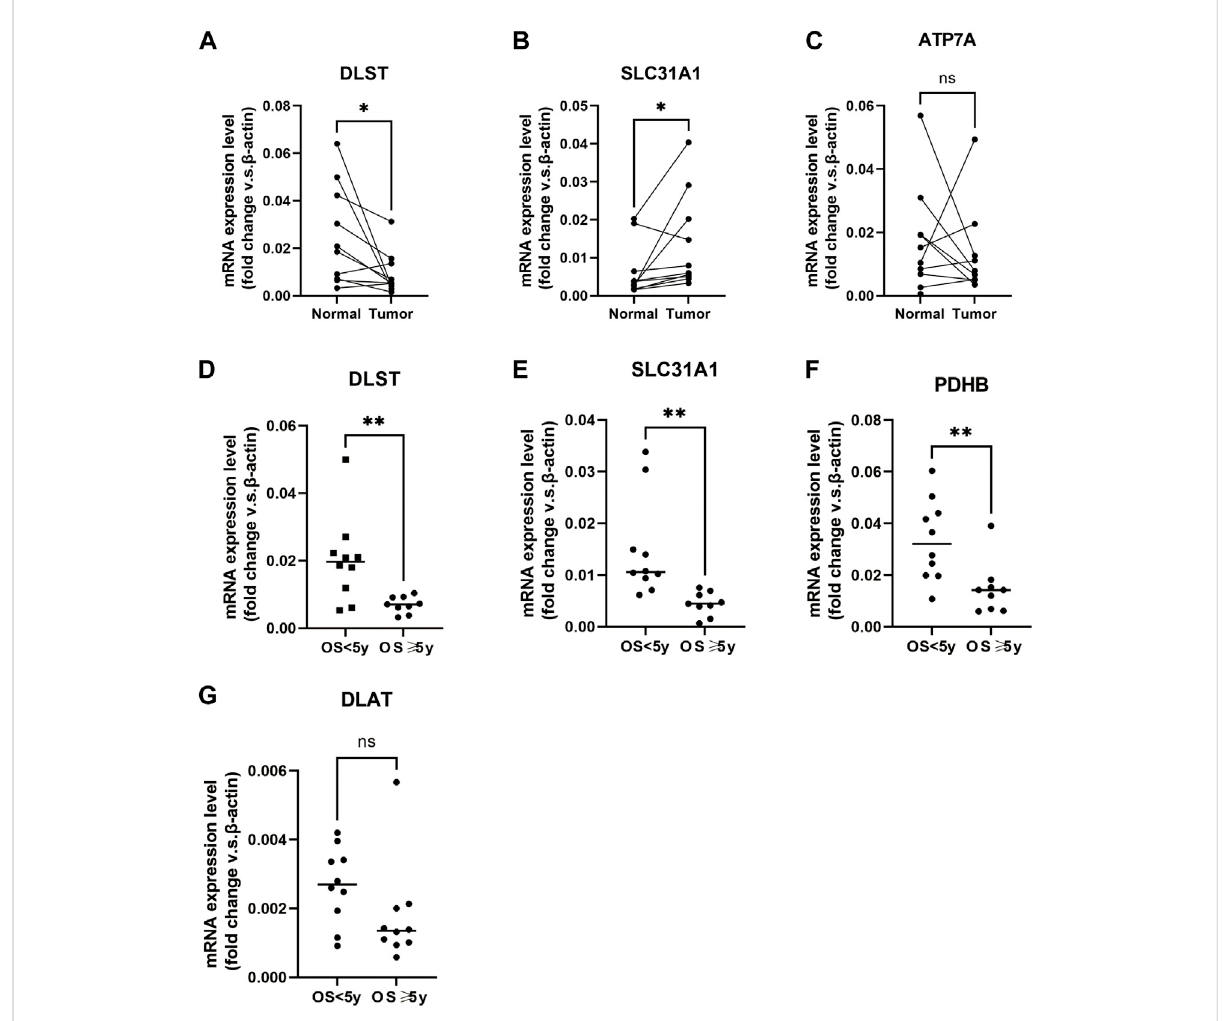
FIGURE 10 Veri fi cation of mRNA relative expression of the CuGs by qPCR (A – C) mRNA relative expression of DLST, SLC31A1, and ATP7A in 10 pairs of normal and tumor tissues of BLCA. (D – G) mRNA relative expression of DLST, SLC31A1, PDHB, and DLAT in 20 tumor tissues of BLCA. ns